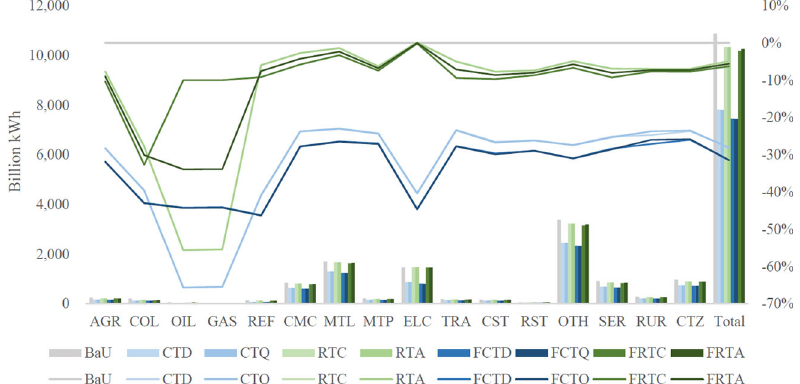
Fig. 11 Electricity consumption in 2030. Blue bars/lines are scenarios imposing carbon taxes, and green bars/lines are scenarios imposing resource taxes. Deeper colors represent free market condition in these scenarios. Please refer to Table 2 for industry